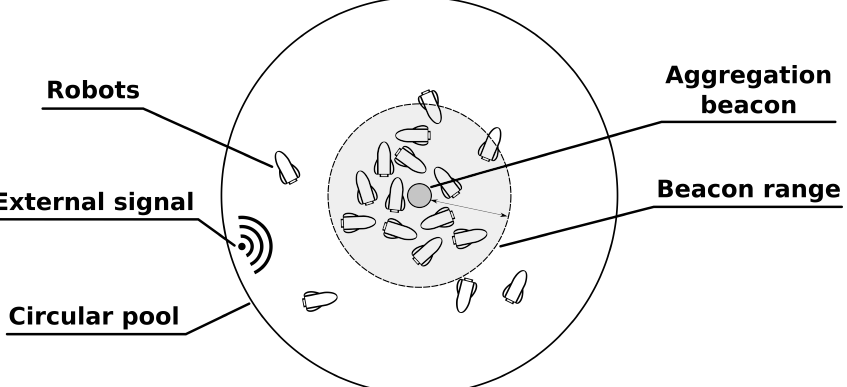
Figure 3. The experimental setup in our simulations is a circular pool (12.5 m diameter), with a beacon in its center that periodically emits acoustic messages and acts as an aggregation device to maintain the robots together (1.75 m range). Conditional and unconditional stimuli can be presented to the robots at any time, by triggering long-range acoustic